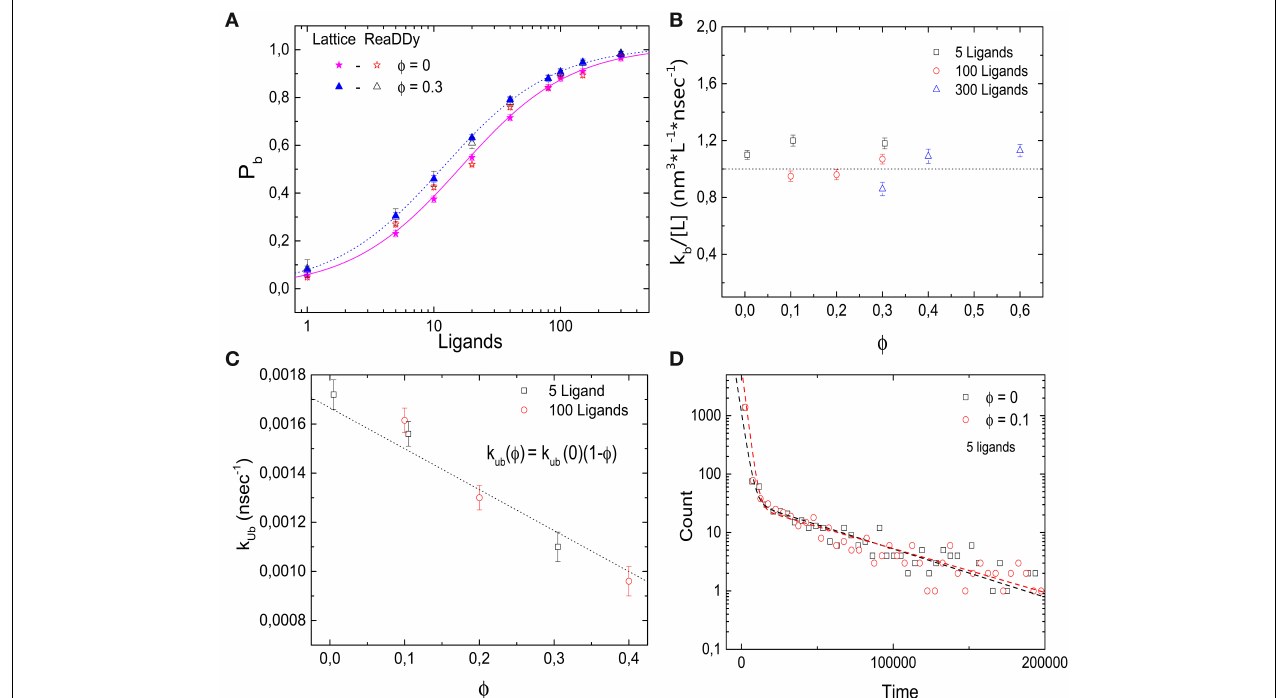
FIGURE 4 | Effects of molecular crowding on binding equilibria simulated with ReaDDy. (A) Probability for the target (receptor) to be occupied P b as a function of the number of ligands, for two levels of volume occupation φ 0 and 0 . 3 . Crowding shifts the probabilities towards lower = number ligands. Similar behavior is observed for the lattice implementation and for ReaDDy. (B) Binding rate k b stays constant as the levels of volume occupation increase. (C) Unbinding rate decays as φ increases, following the